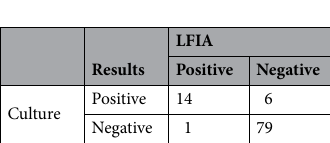
Table 3. Comparing culture and LFIA results.